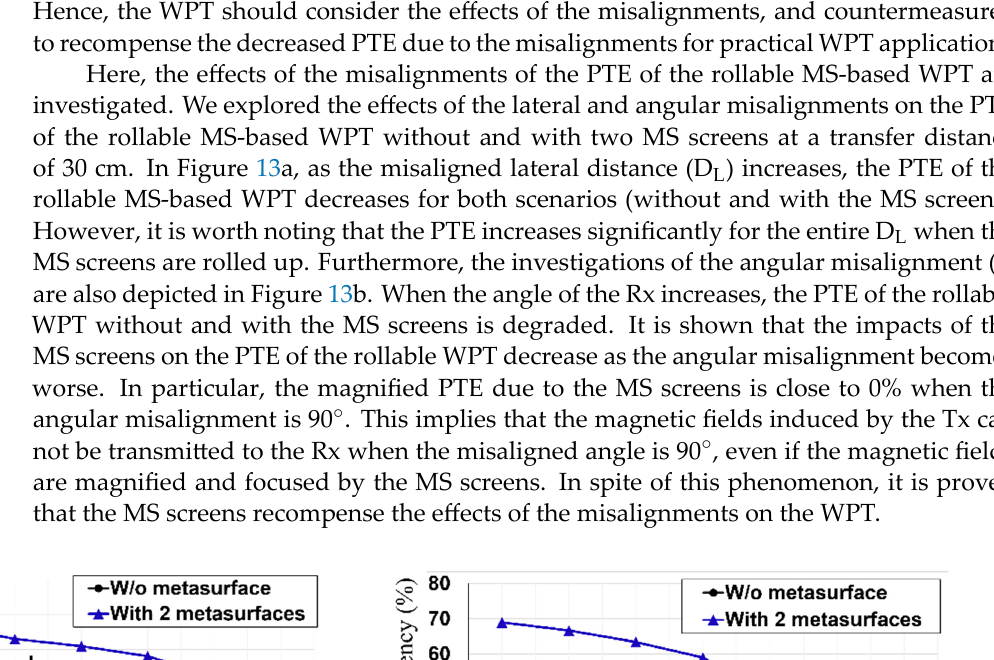
Table 2. Comparison of this work with other MTM- or MS-based WPT systems.